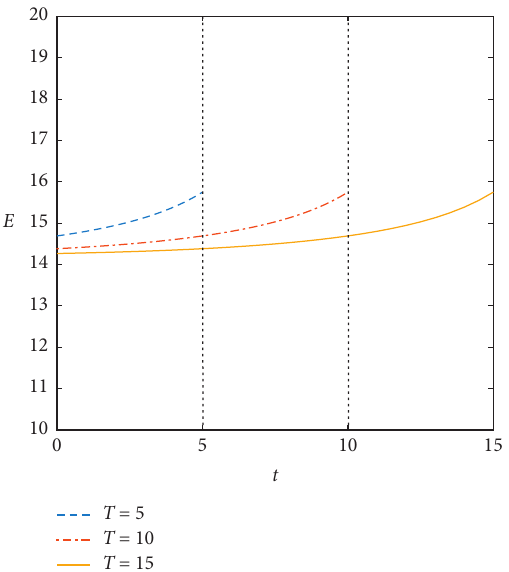
Figure 19: Trajectory curve of optimal instantaneous emission rate under non-cooperation when the planning period T � 5 , T � 10, and T � 15.